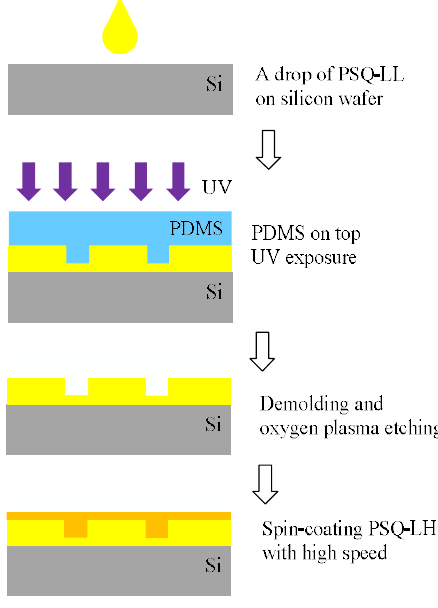
Figure 3. Fabrication process of the inverted ridge waveguide using UV soft imprinting technique [35].